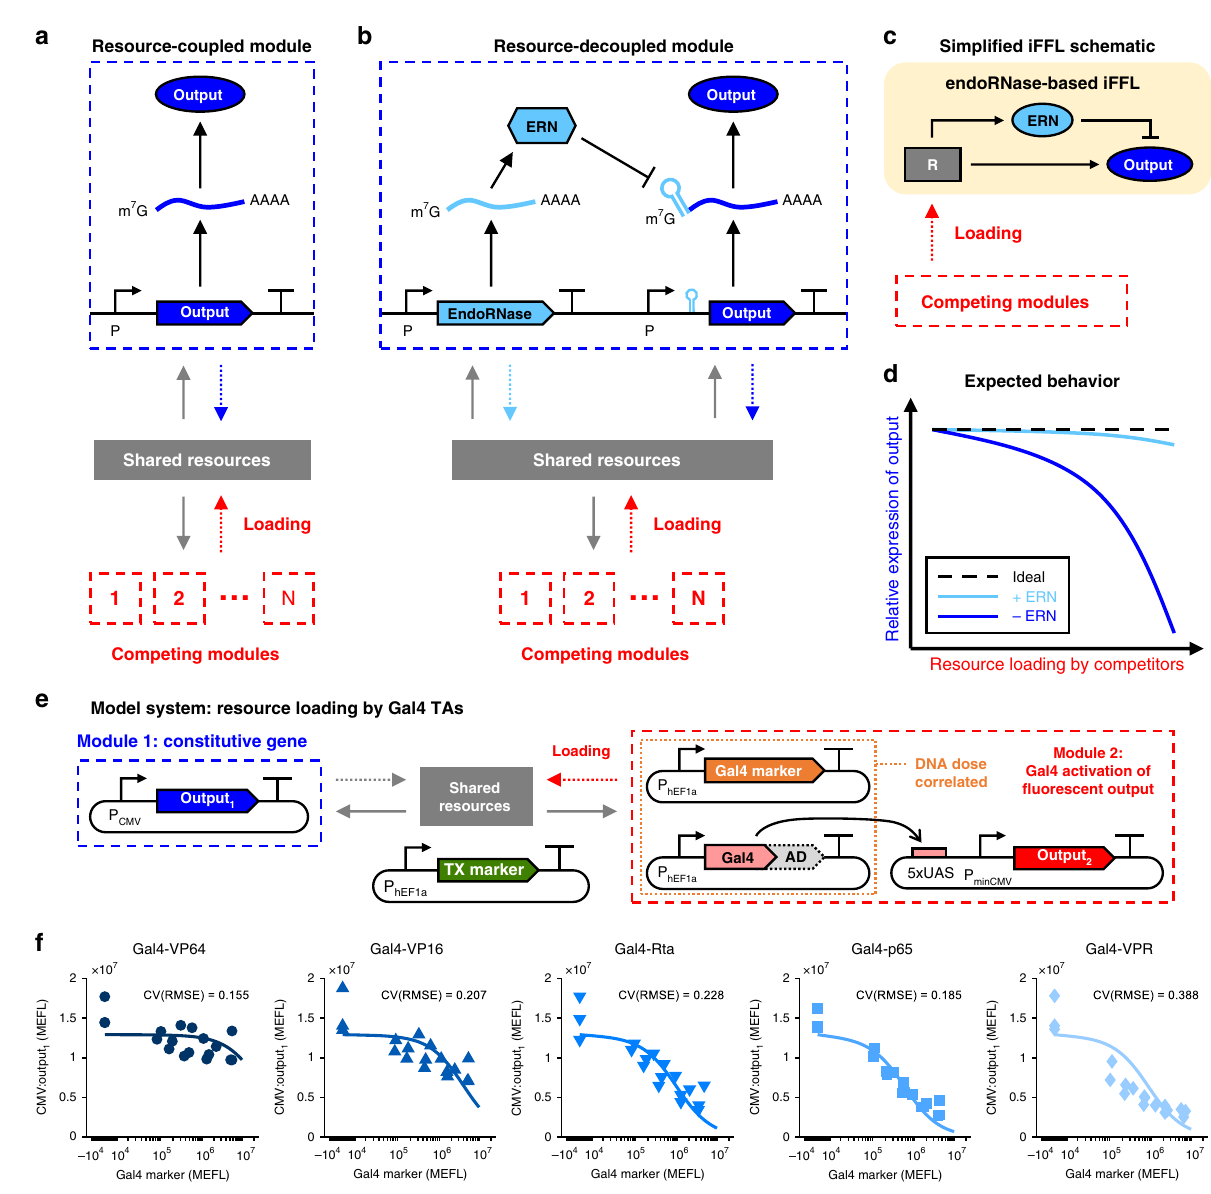
Fig. 1 Feedforward control strategy to decouple modules that share limited resources. a A genetic module comprising a single constitutive transcription unit. Other competing modules place a load (indicated by the dashed red arrow) on the free cellular resources, affecting the expression of the module of interest (resource-coupled module). The module of interest also applies a load to the resources (indicated by the dashed blue arrow). b An incoherent feedforward loop (iFFL) device within the module of interest decouples the module ’ s output from resource variability. An endoribonuclease (endoRNase/ ERN), produced by an identical promoter as that of the output, represses the output by binding to a speci fi c target site in its 5 ′ untranslated region (UTR) and cutting the mRNA. c A simpli fi ed schematic of the iFFL showing cellular resources ( R ) as a disturbance input to the iFFL. d The expected behavior of the output of the resource-coupled ( − ERN) and resource-decoupled ( + ERN) modules in response to resource loading by other modules. e Experimental model system to recapitulate resource loading. The module of interest comprises a constitutively expressed protein (output 1 , mKate2). In a competitor module, Gal4 transcriptional activators (TAs) drive expression of another protein (output 2 , EYFP). Different activation domains (ADs) were fused to the DNA- binding domain (DBD) of Gal4. A reporter (Gal4 marker, TagBFP) was titrated together with the Gal4 TAs to mark their delivery per cell. The TX marker is iRFP720. f Dose-dependent effect of Gal4 TAs on output 1 for different ADs (VP64, VP16, Rta, p65, VPR). The markers indicate median expression levels from three experimental repeats. The lines represent fi ts of our resource competition model (equation (50), see Supplementary Note 2 and Supplementary Fig. 5). Dose – response curves and model fi ts for output 2 are shown in Supplementary Fig. 2. The CV(RMSE) is the root-mean-square error between the model and data, normalized by the mean of the data. All data were measured by fl ow cytometry at 48 h post transfection in HEK-293FT cells. All measurements were made on cells gated positive for the transfection marker (TX marker) or output 1 , and are shown separately for each of three experimental repeats. MEFLs are calibrated fl ow-cytometry units as described in “ Methods ” . Median values and fi t parameters are provided in Source